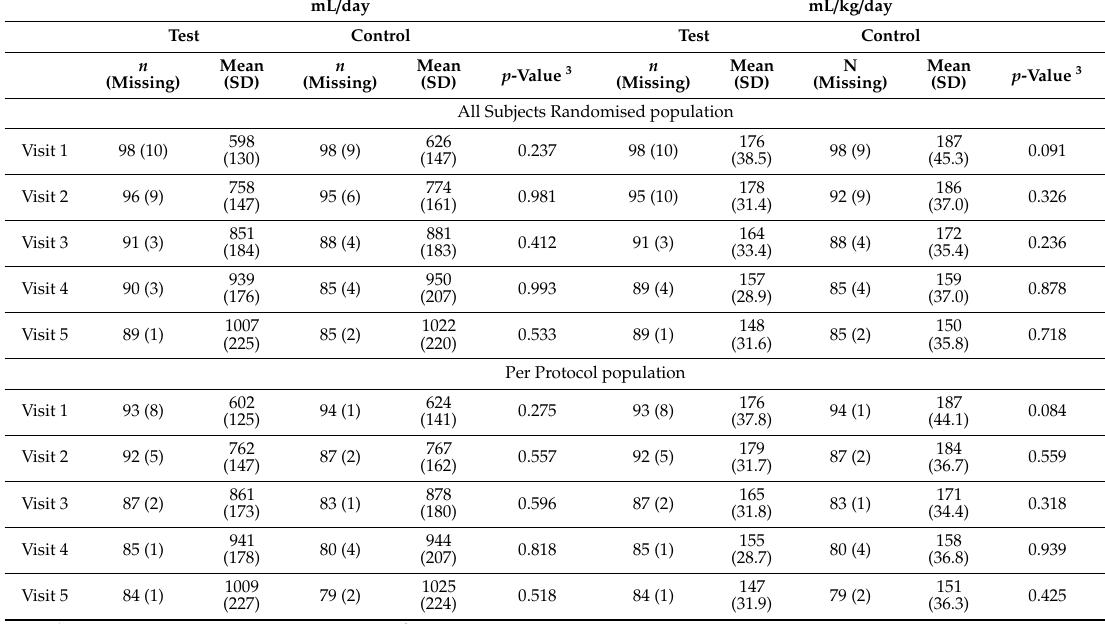
Table 3. Daily infant formula intake per day and per kg body weight 1,2